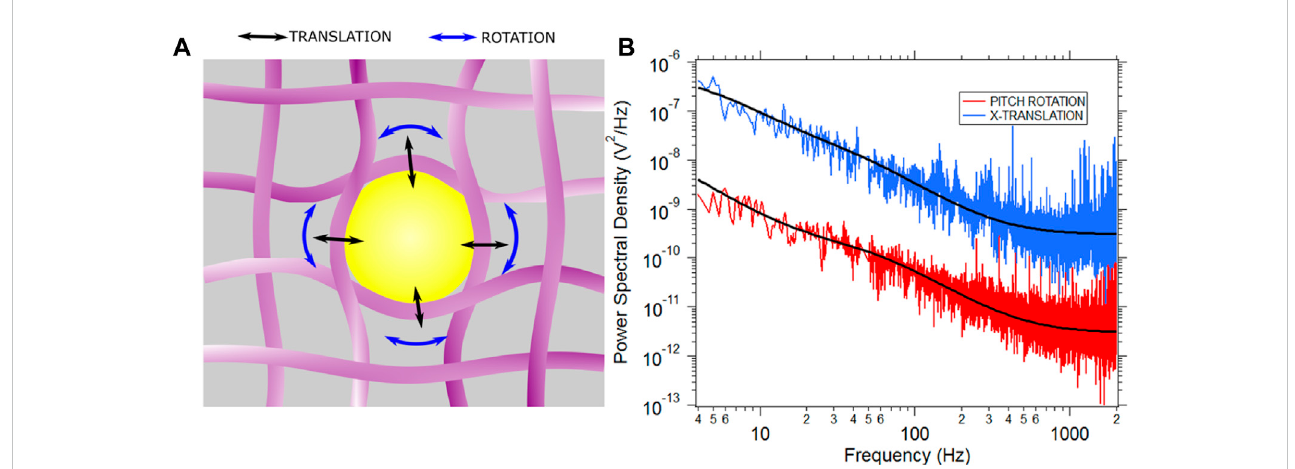
FIGURE 2 (A) A particle in the cytoplasm gets enmeshed in the meshlike network of cytoskeletal fi bres. The cartoon is not to scale and is for representational purposesonly. (B) TypicalPSDforX(translation)andpitch(rotation)motionisshowninblueandredrespectively.BothPSDsare fi ttedwiththeJeffery ’ smodel + 1 (cid:2) 3 ± 1, λ = .009 ± .002 s for translational mode, and μ p for viscoelasticity which yields the values μ p μ s as the fi tting parameters.